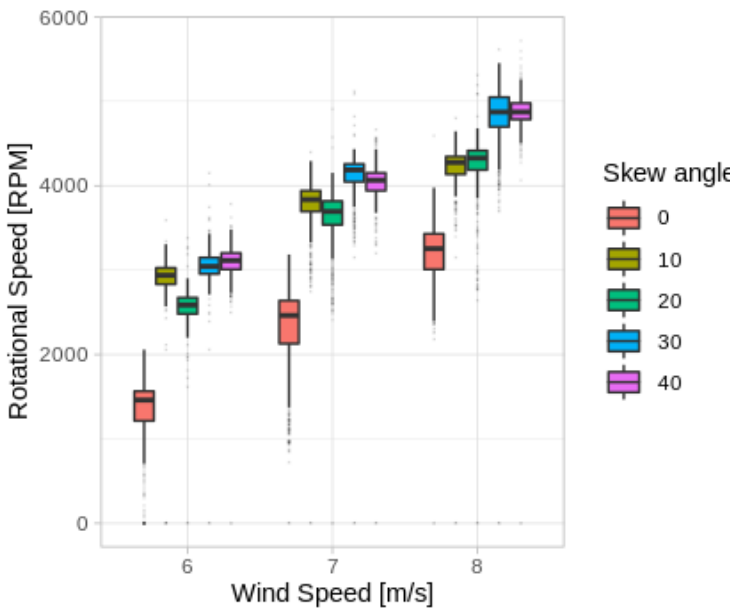
Figure 5. Boxplots of rotational speed of the small-scale longitudinal turbine at different wind speeds and skew